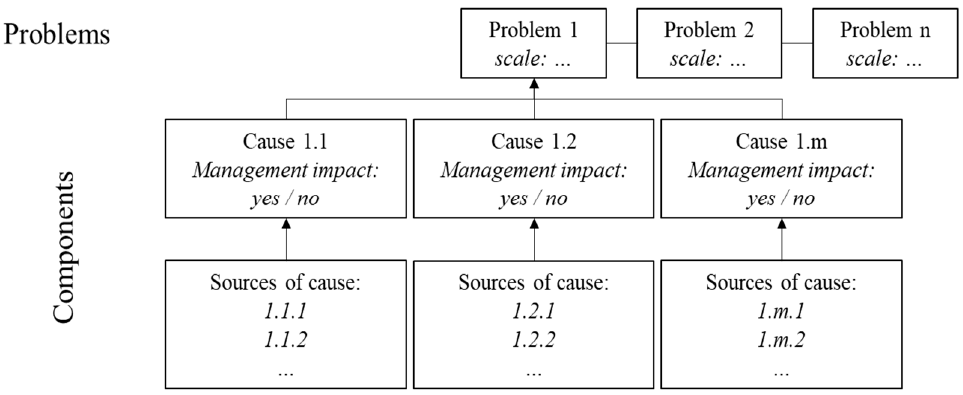
Figure 1. “Network graph” of the tasks to be solved within the framework of the national project, compiled by the